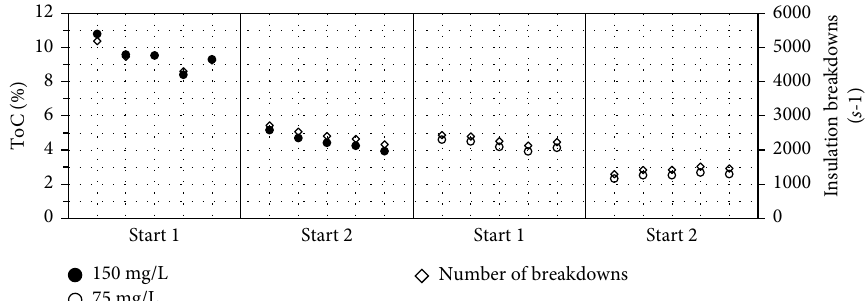
Figure 6: Particle-initiated breakdowns when the bearing is lubricated with Sample A1, with particle concentrations of 150 mg/L and 75 mg/L. At a given concentration, the ToC in Start 2 reduces to approximately half the value of Start 1. The number of breakdowns (per second) is shown on the secondary y -axis.